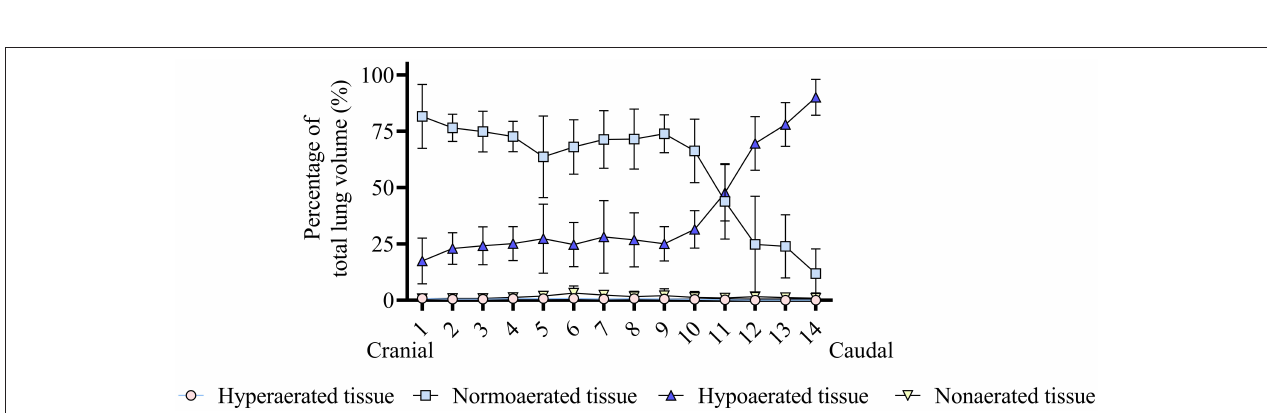
FIGURE 3 | Analysis of lung aeration data obtained by computed tomography (CT) scans during an end-expiratory pause in six obese dogs undergoing anesthesia. (A) Whole lung aeration analysis. Hyper, hyperaerated; Normo, normoaerated; Hypo, hypoaerated; Non, nonaerated. (B) Regional analysis of aeration in the ventrodorsal direction is shown. Since dogs were in dorsal recumbency, the ventral region represents the nondependent lung and the dorsal region represents the dependent lung. * p < 0.05 compared to normoaeration in the ventral and intermediate regions; # p < 0.05 compared to hypoaeration in the ventral and intermediate regions.